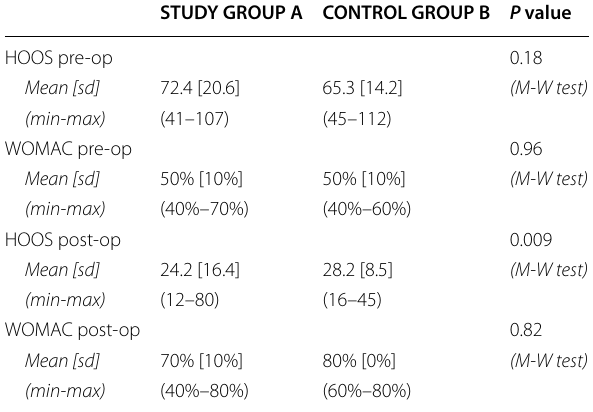
Table 3 Clinical outcomes pre and postoperative in both